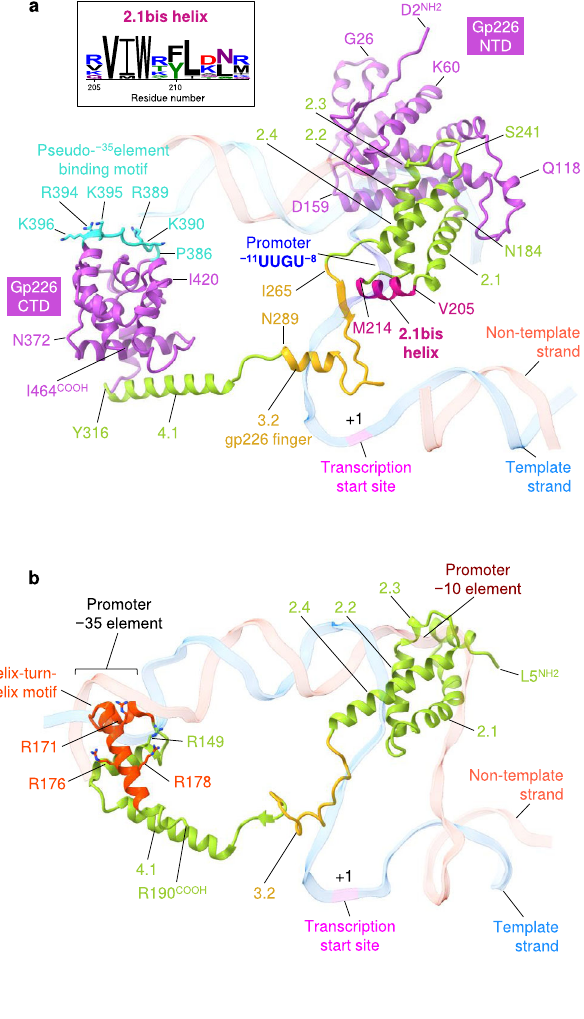
Fig. 5 Cryo-EM structure of the AR9 nvRNAP holoenzyme. a Cryo-EM map of the AR9 nvRNAP holoenzyme (AR9 nvRNAP-holo-cryoEM) contoured at 4.0 std dev above the mean (semitransparent gray) with the fi tted as a rigid body atomic model of the AR9 nvRNAP promoter complex sans DNA (AR9 nvRNAP-Pro-Xray) and is colored as in Fig. 2a. b A zoomed-in view of the catalytic cleft demonstrating the degree of gp226 disorder. DNA (albeit with small modi fi cations for the latter) have been retained. A Protein Data Bank-wide search 26 for folds resembling that of the gp226 NTD and CTD resulted in a single de fi nitive match.